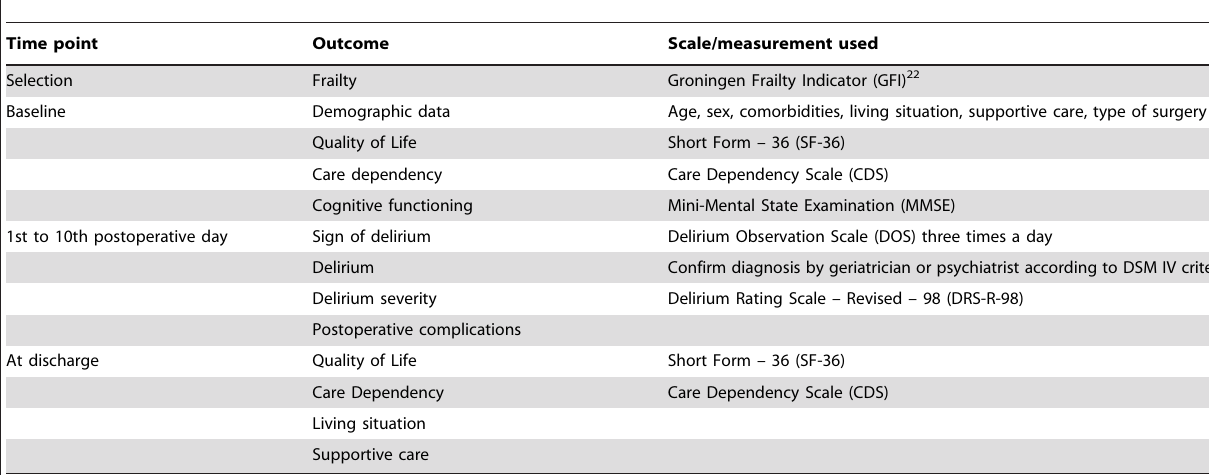
Table 2. Overview of assessments used in the LIFE